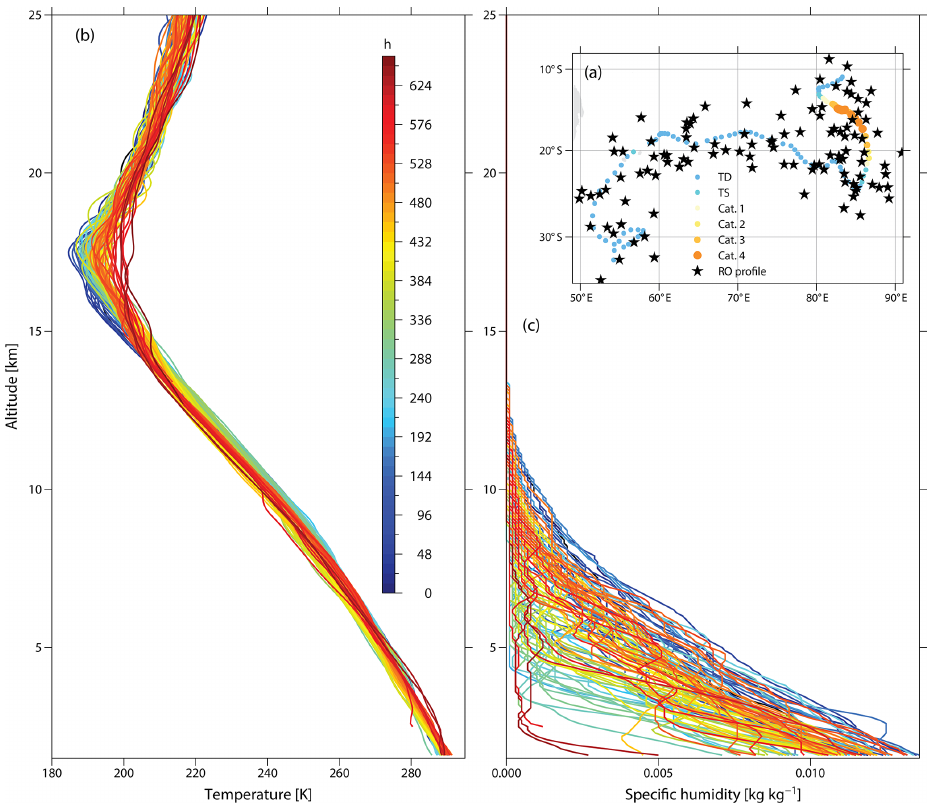
Figure 4. Temporal evolution of the Typhoon Hondo in 2008. Hondo best track and co-located ROs (a) . Temperature (b) and specific humidity (c) profiles from the surface to 25km of altitude since the beginning to the end of the storm.